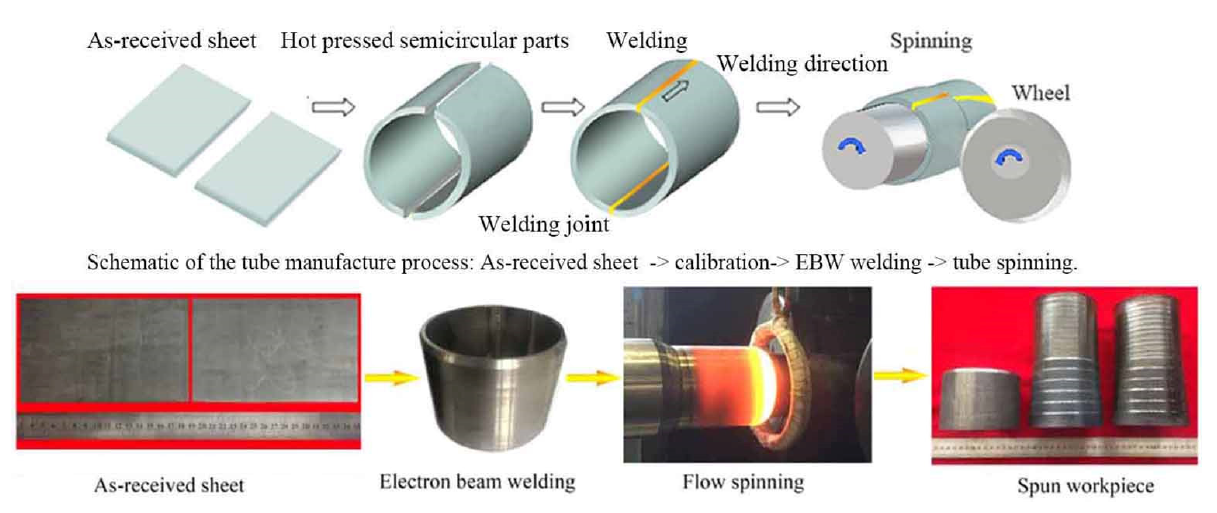
Figure 1. Schematic of hot power spinning assisted by on-line electro-magnetic induction heating.